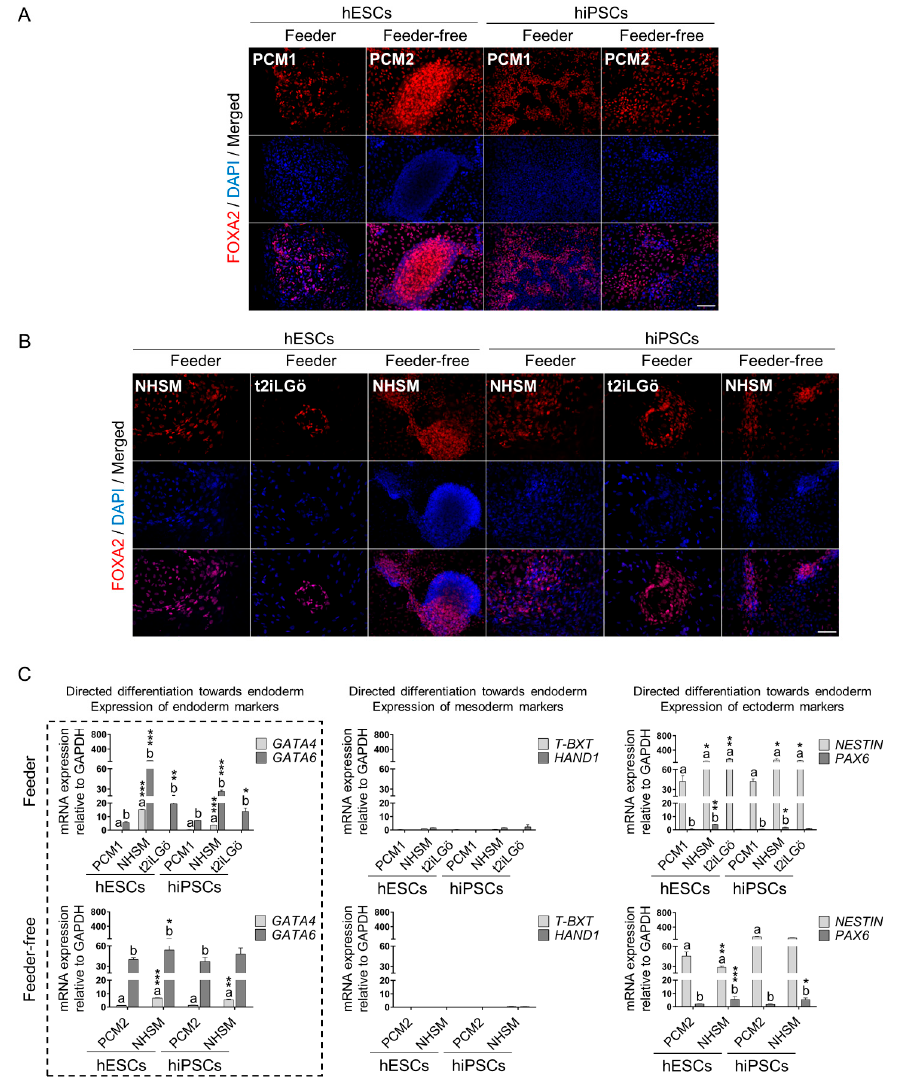
Figure 4. Endoderm layer directed differentiation of primed and naive hPSCs (hESCs, hiPSCs). ( A , B ) Immunofluorescence analysis of endoderm specific marker (FOXA2) on primed and naive hPSCs on feeder and feeder-free cultures. Scale bar, 100 μ m. ( C ) Gene expression analysis for endoderm specific genes ( GATA4 and GATA6 ) on feeder and feeder-free hPSCs cultures. Specific genes for mesoderm ( T-BXT and HAND1 ) and ectoderm ( NESTIN and PAX6 ) were also analyzed in order to determine the lineage heterogeneity in the differentiation procedure. The dashed box represents the gene expression for endoderm-specific markers. All comparisons are relative to primed media (a* compared to a and b* compared to b. * p < 0.1, ** p < 0.01 and *** p < 0.001). Data are represented as mean ±